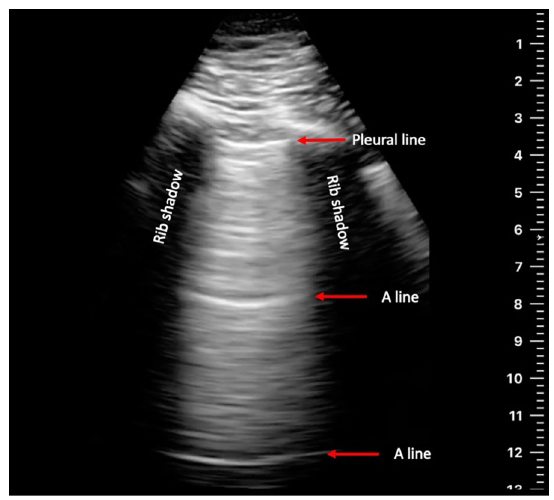
Fig. 2 Representative image of a patient‑performed ultrasound